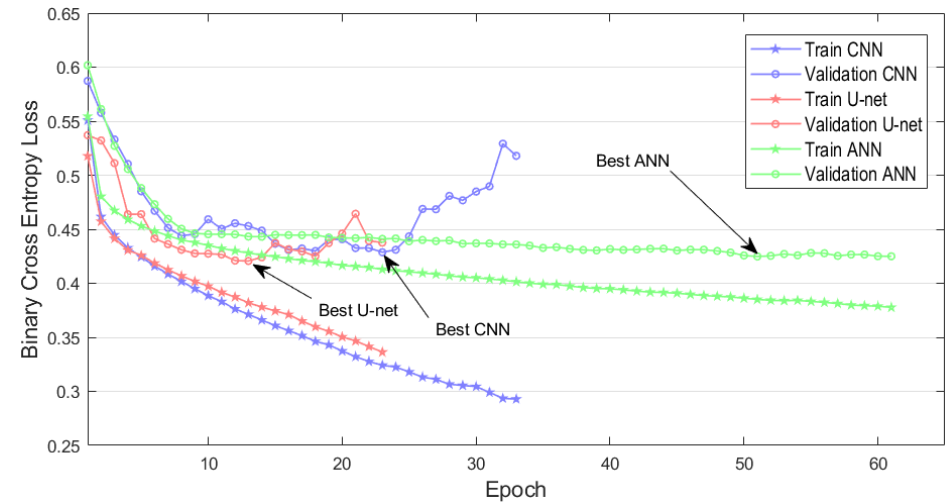
Figure 20. Binary cross entropy loss vs epoch curve of different models, the black arrow showed the best model position as we used an early stop with patience = 10 on the TensorFlow software.